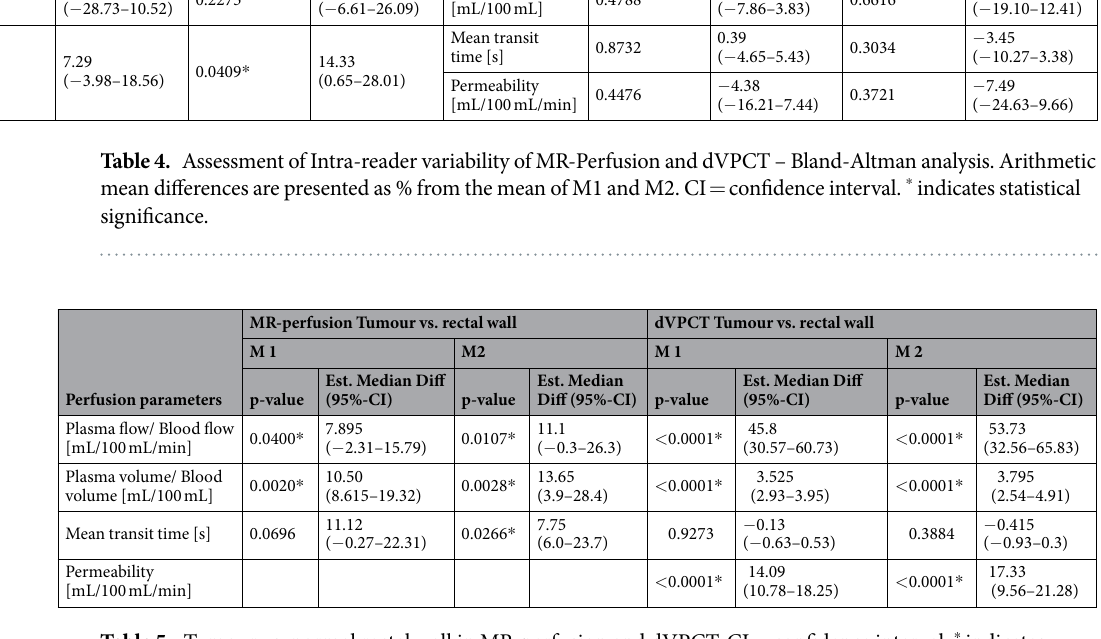
Table 5. Tumour vs. normal rectal wall in MR-perfusion and dVPCT. CI = confidence interval. * indicates statistical